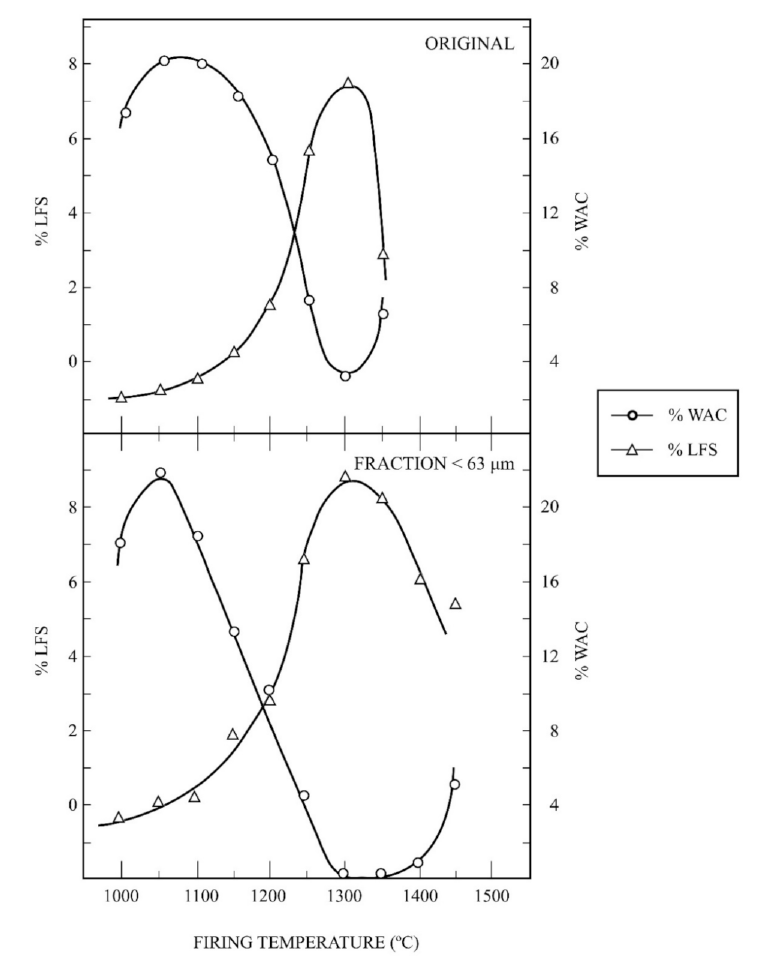
Figure 7. Thermal behaviour of the raw kaolin sample (labelled as ORIGINAL) and fraction under 63 µ m: plot of the variation of linear firing shrinkage (LFS) and water absorption capacity (WAC) as a function of firing temperature.